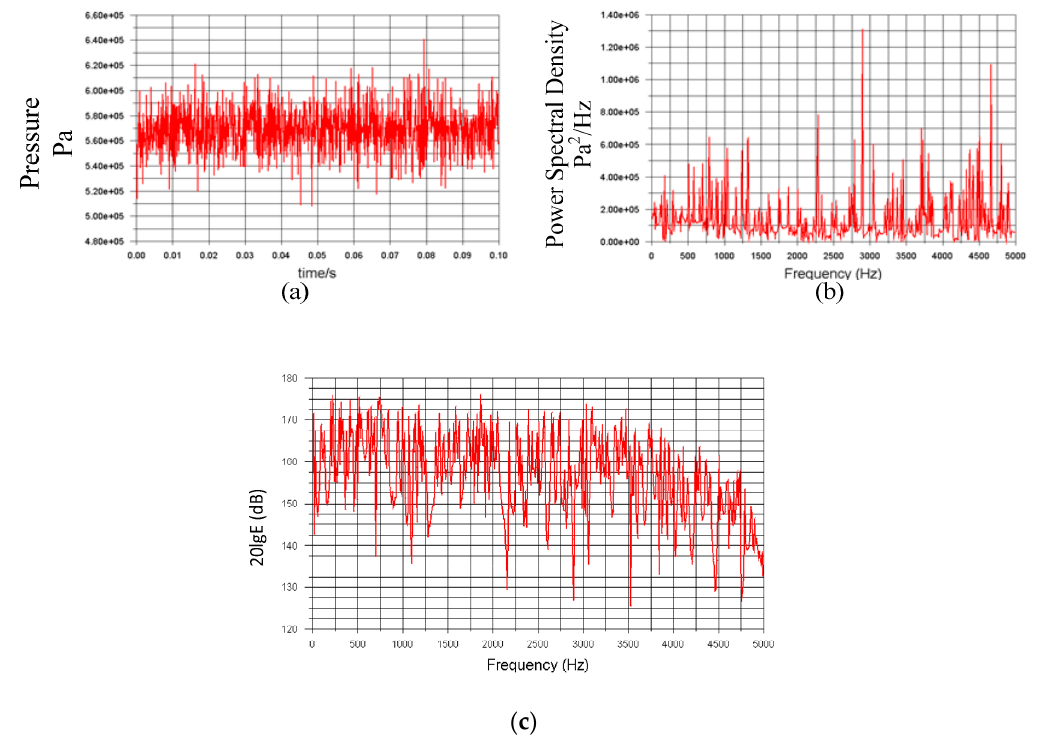
Figure 9. Pressure curves in time and frequency domains when the inlet velocity is 25 m / s. ( a ) Time domain. ( b ) Frequency domain. ( c ) 20logE frequency